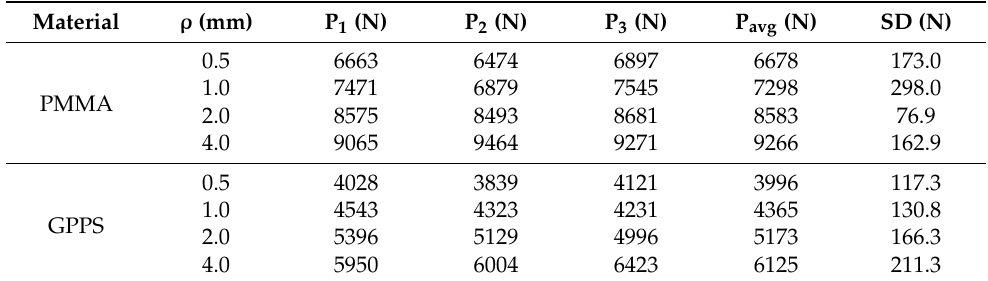
Table 2. Experimentally achieved load-carrying capacities (LCCs) for the U-notched specimens made of PMMA and GPPS. SD: standard